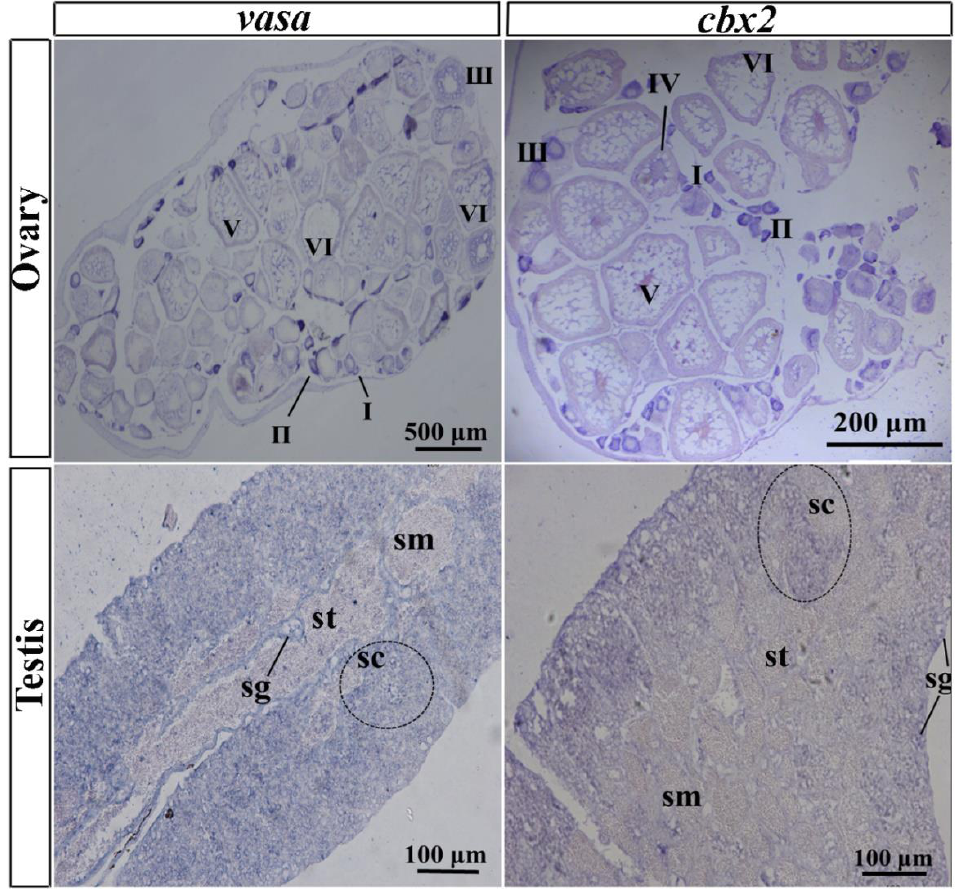
Figure 5. Digoxigenin (DIG)-labeled in situ hybridization (ISH) in medaka ovaries and testes. Paraffin sections were hybridized with the antisense probe of cbx2 and vasa . Signals were visualized using chromogenic staining. I – VI, oocyte stage; sg, spermatogonia; sc, spermatocytes; st, spermatid; sm, sperm.